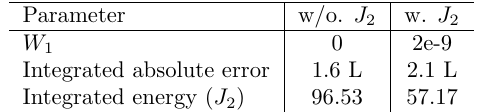
Table 2: Results with and without energy cost.